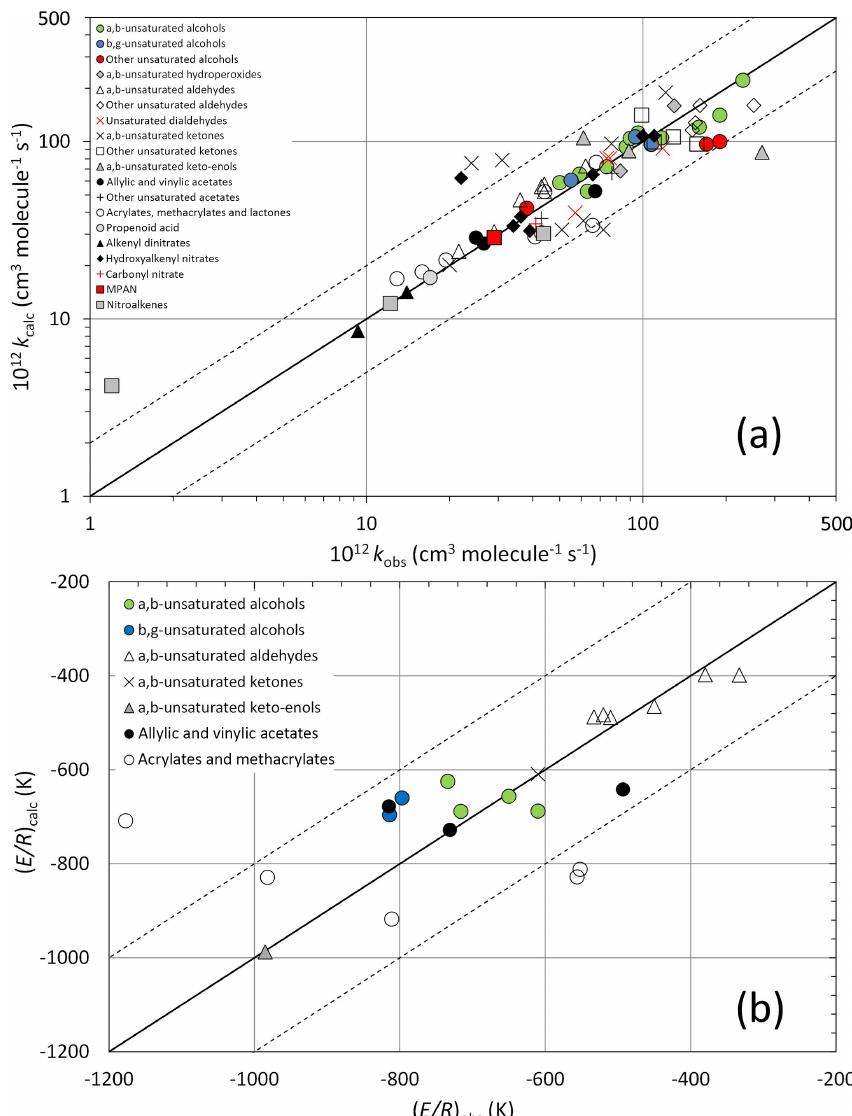
Figure 7. (a) A log–log correlation of k calc and k obs at 298K for unsaturated organic oxygenates. The broken lines show the factor of 2 range (see Table S1 for identities of outliers). (b) A correlation of the temperature coefficients (E/R) calc and (E/R) obs for the same compound classes. The broken lines show the ± 200K